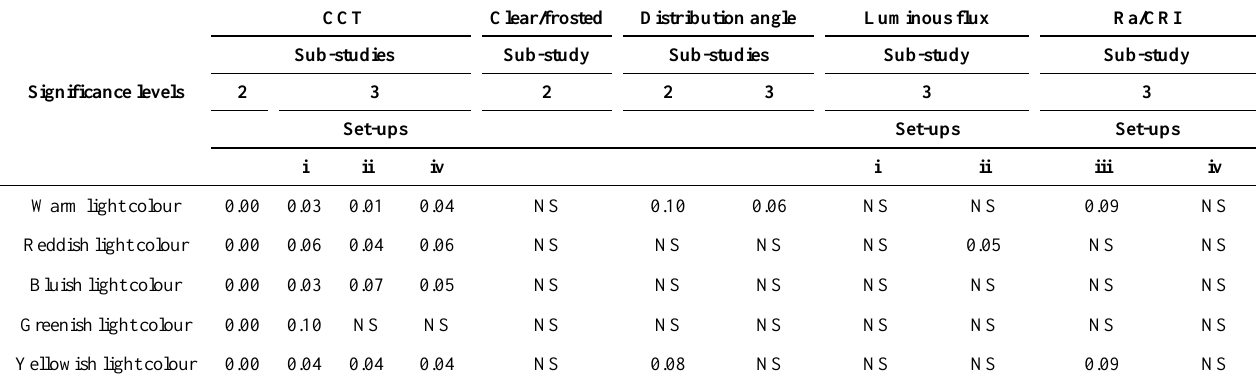
Table 4. Significance levels for regressions of the effect of product properties on assessed concepts of light colour, results from tests performed in sub-studies 2 and 3. A value of 0 or close to 0 indicates a significant effect, while NS indicates no significant effect ( p > 0.10)